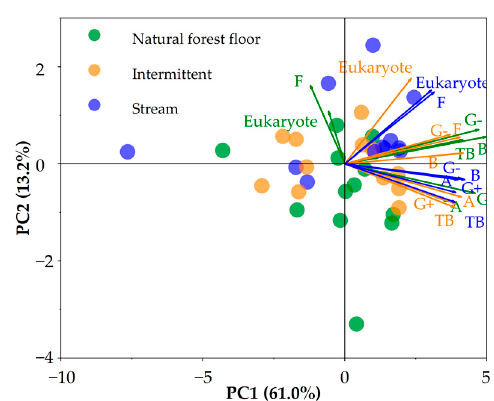
Figure 2. Principal components analyses of PLFA profiles (log 10 transformed mol) on litter at three habitats. PLFAs in green, orange and blue font represent the natural forest floor, the intermittent stream and stream samples, respectively. TB: Total Biomass, B: Bacteria, F: Fungi, G+: G+ bacteria, G − : G − bacteria, A: Actinomycete. Table 1. Linear regression for three habitats between the first and second principal components (PCA-1, PCA-2) after the PCA and the concentrations of microbial PLFA. Asterisks denote significant influences of the concentrations of microbial PLFA on the data variation represented by PCA-1